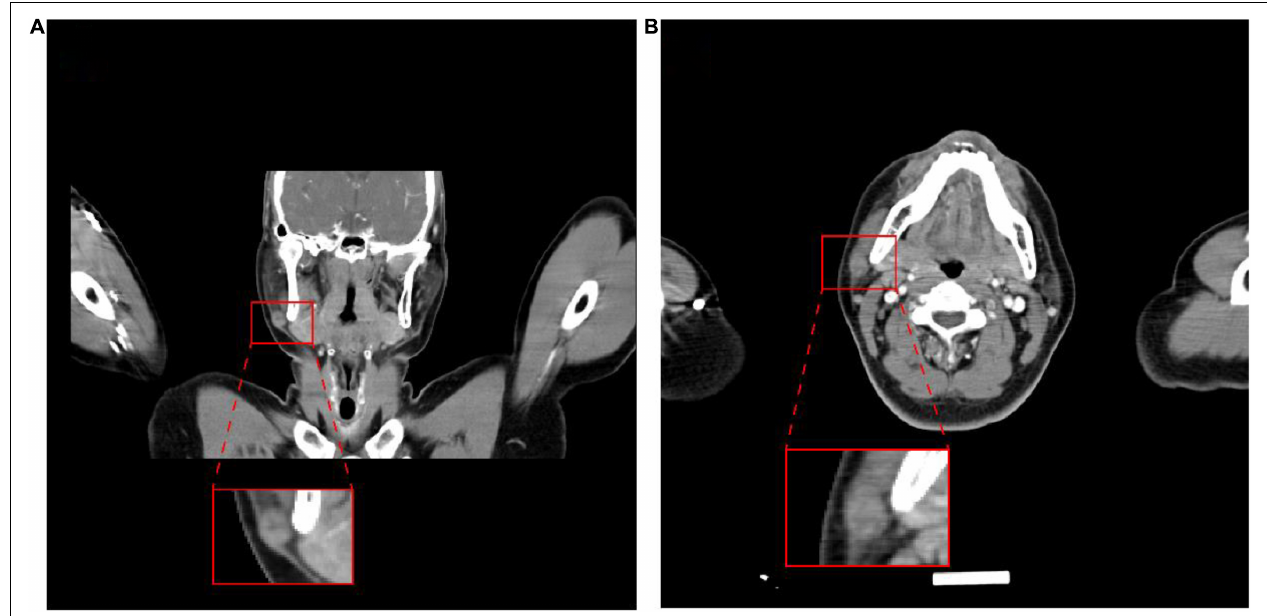
FIGURE 1 | Images of the tumor. Computed tomography showed a nodule on the lower right side of the parotid gland. (A) Coronal plane; (B) transverse plane.